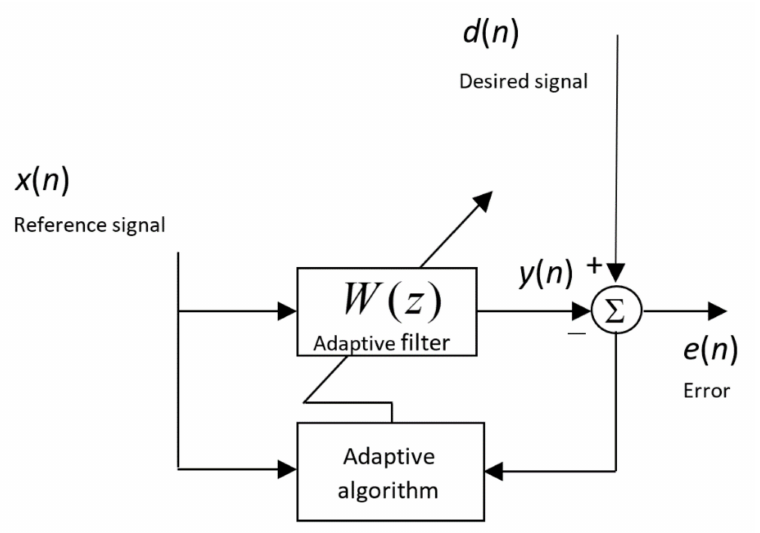
Figure 6. Block diagram of the noise attenuation experiment used to compare different adaptive